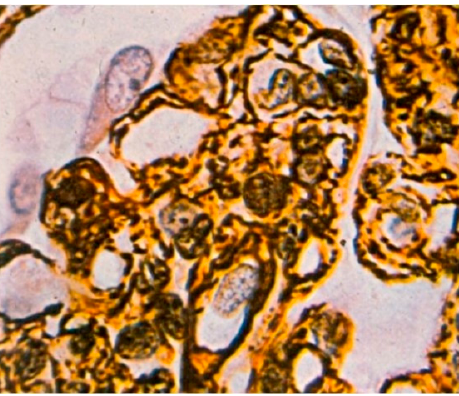
Figure 5. Double-contouring of the walls of the capillary loops. Impregnation with silver-containing salt according to a Jones stain, 400 × magnification.